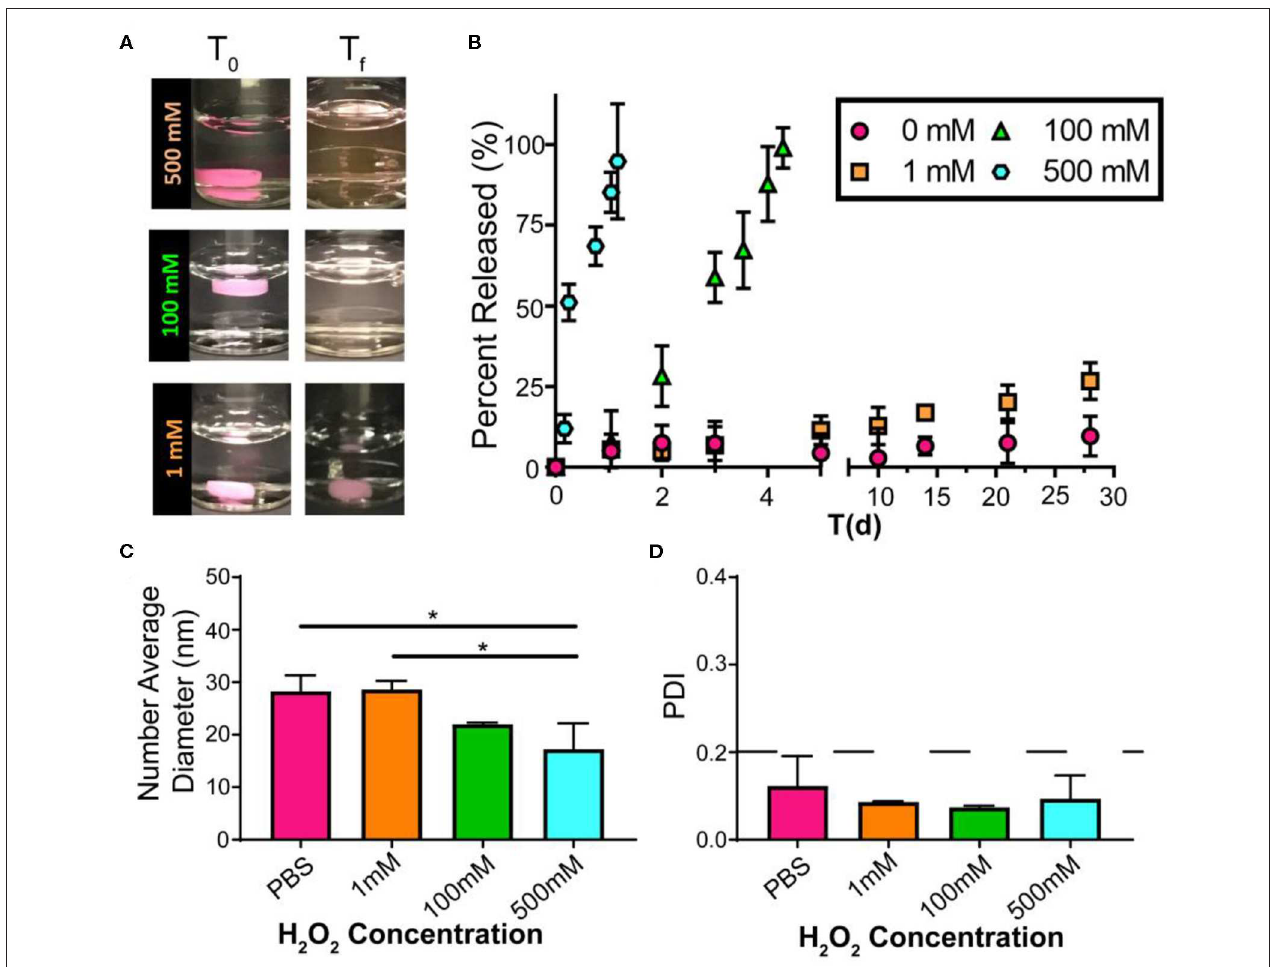
FIGURE 3 | Drug release from FM-depots dependent on the concentration of the oxidizer. (A) Pictures of DiI-loaded FM-depots in PBS before and after adding different concentrations of H 2 O 2 (1, 100, and 500mM). (B) in vitro release kinetics of DiI-loaded MC from the hydrogels upon oxidation with different H 2 O 2 concentrations over 30 days. (C,D) Average diameters and PDI of DiI-loaded nanostructures in the supernatant released from DiI-loaded FM-depots. N = 3. Two-tailed t -tests were used for statistical significance: * p <